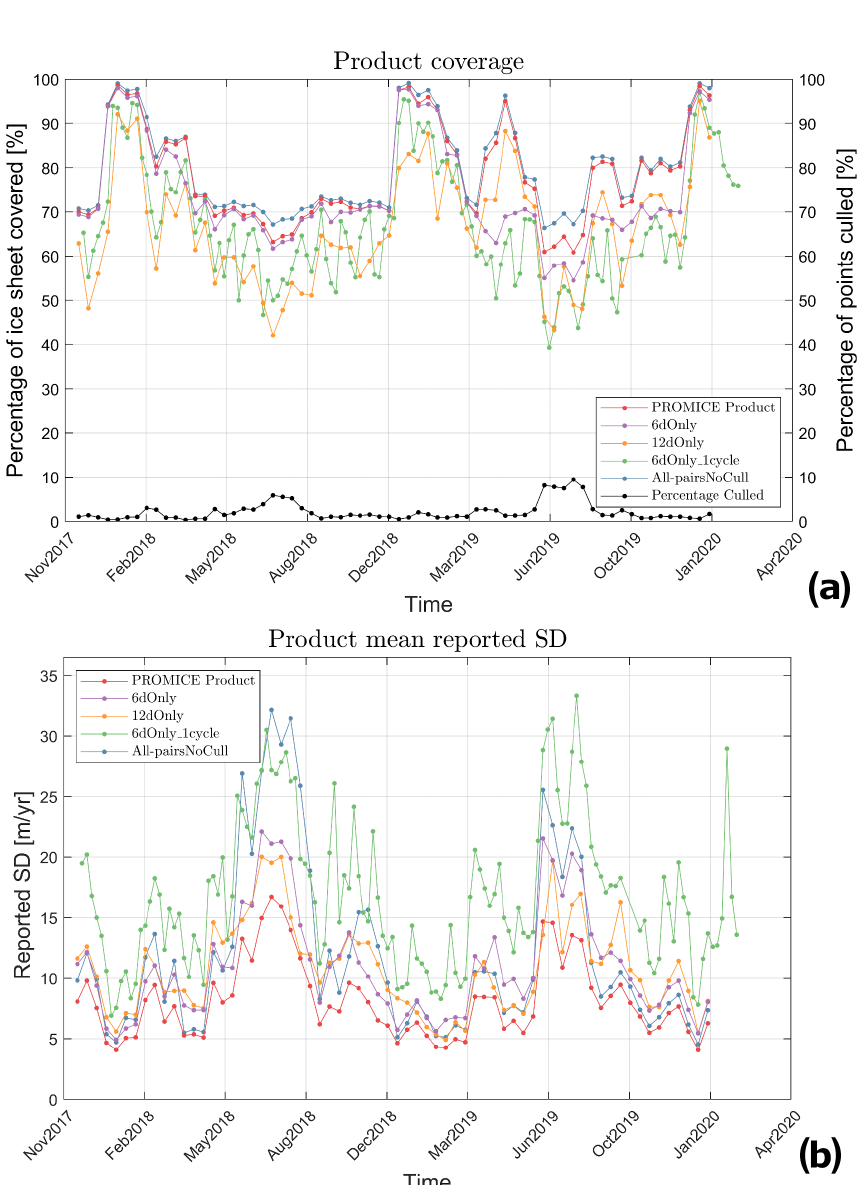
Figure 10. (a) The left axis shows the percentage of the ice sheet that is covered by data for each mosaic. Right axis: the lower blue curve shows the percentage of pixels that have been culled for the PROMICE product using the procedure described in Sec. 4.4. (b) The mean reported standard deviation for each